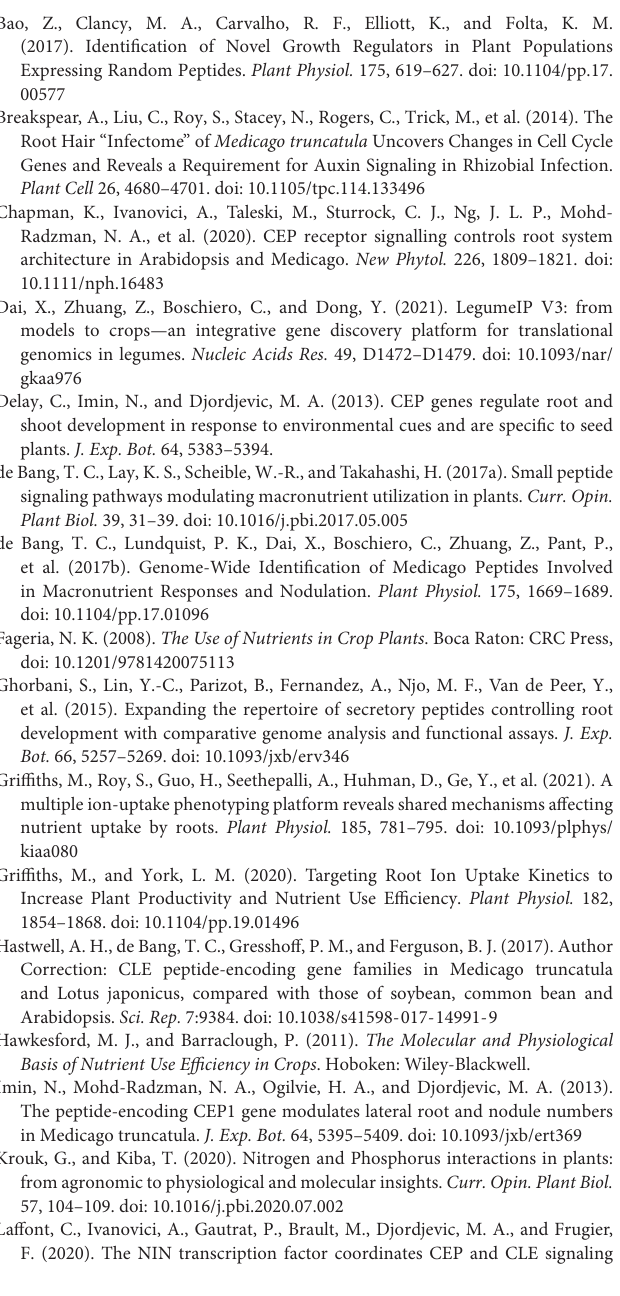
nutrient media composition. Supplementary Table 5 | Table showing RNAseq read statistics for peptide treatments presented in this